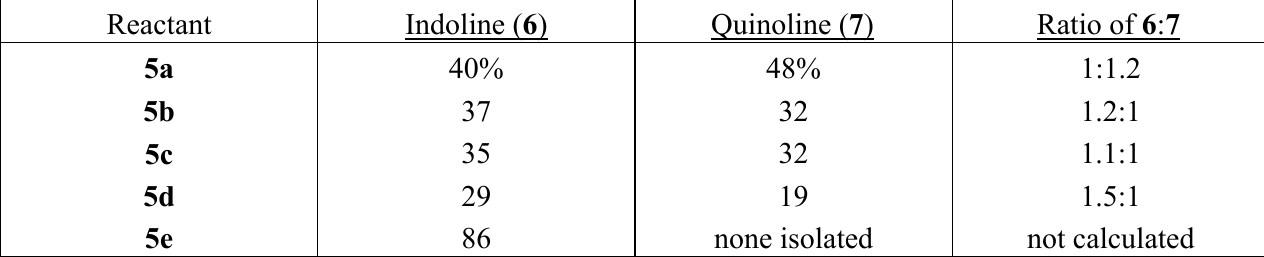
Table 1. Summary of the percent yields and product ratios resulting from the radical cyclizations of bromoallylic chlorides 5a-e